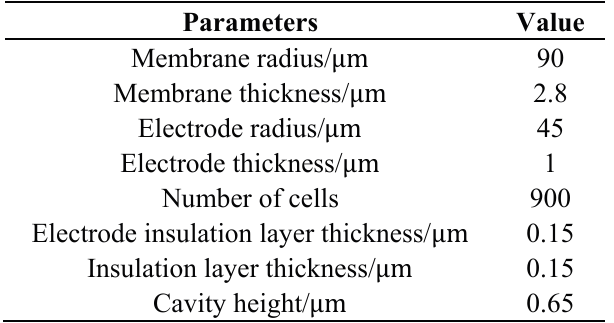
Figure 1. ( a ) The cross-section of a sensitive cell; ( b ) The planform of an element. Table 1. The parameters of designed CMUT